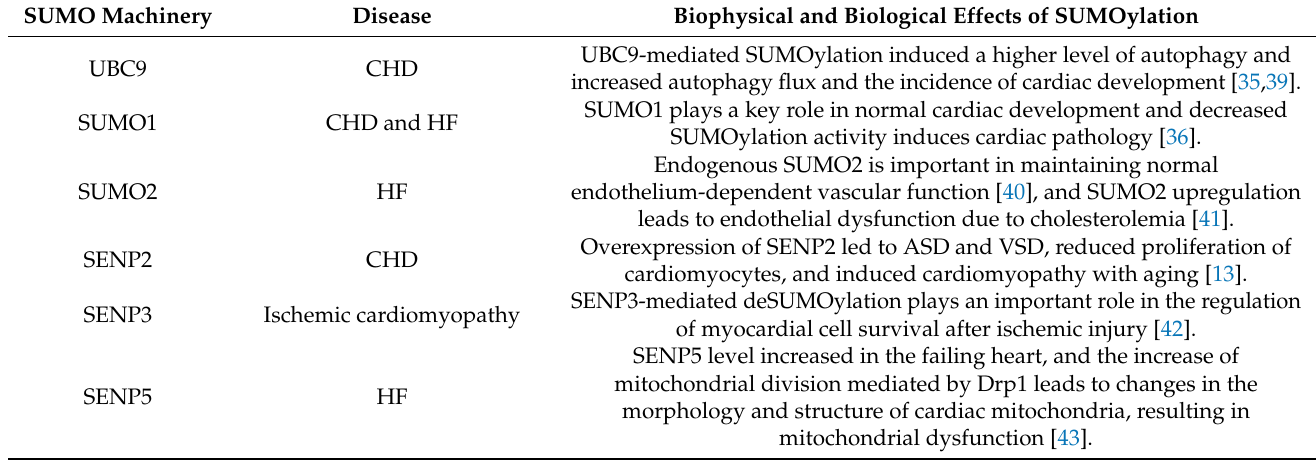
Table 1. SUMO machinery and CVD.